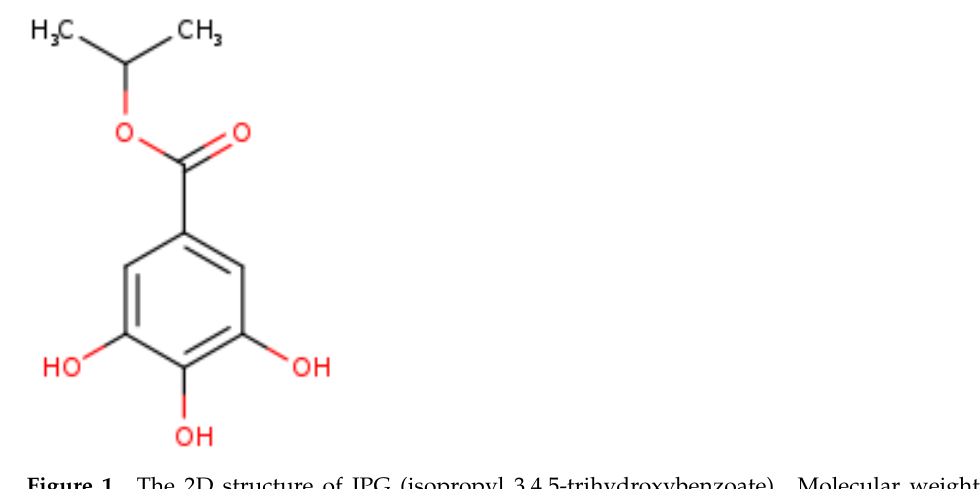
Figure 1. The 2D structure of IPG (isopropyl 3,4,5-trihydroxybenzoate). Molecular weight of 212.20 g/mol. Source: Swiss ADME, 2021.